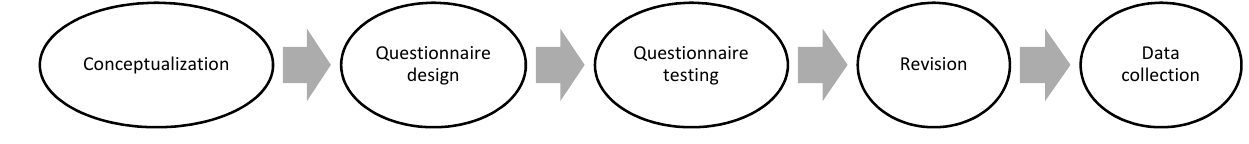
Figure 1. Methodology for survey design. Source: see [1].